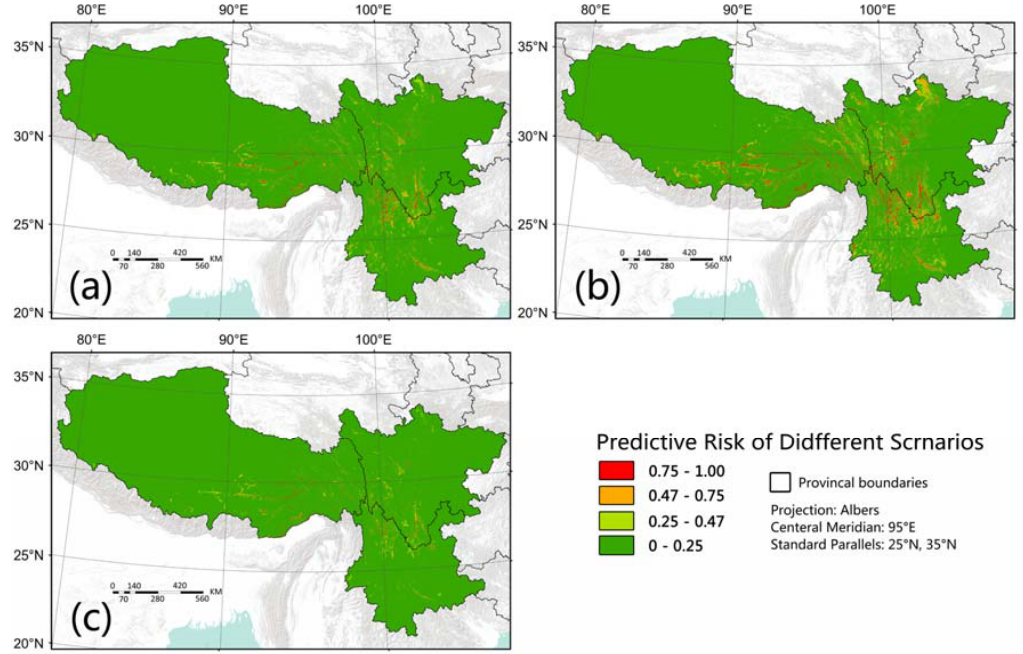
Figure 5. Predicted risk of bacillary dysentery in different hypothetical scenarios. (Scenarios ( a ): GRP per square kilometer of the under developed places are improved to the contemporaneous level of that in the urban area of Lhasa. Scenarios ( b ): the number of hospital beds rise by one level. Scenarios ( c ): both ( a ) and ( b